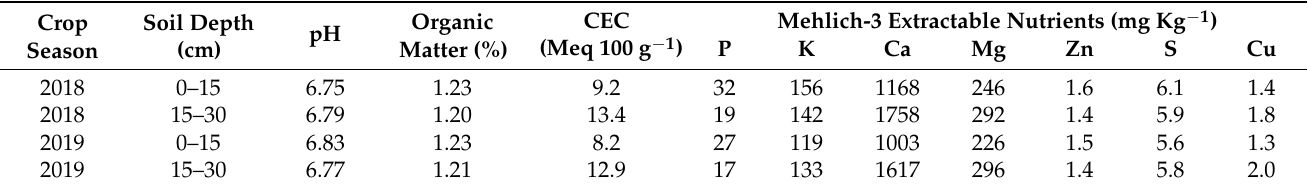
Table 4. Selected chemical properties of research fields used for experiments in Stoneville, MS, in 2018 and 2019. Soil Crop Season